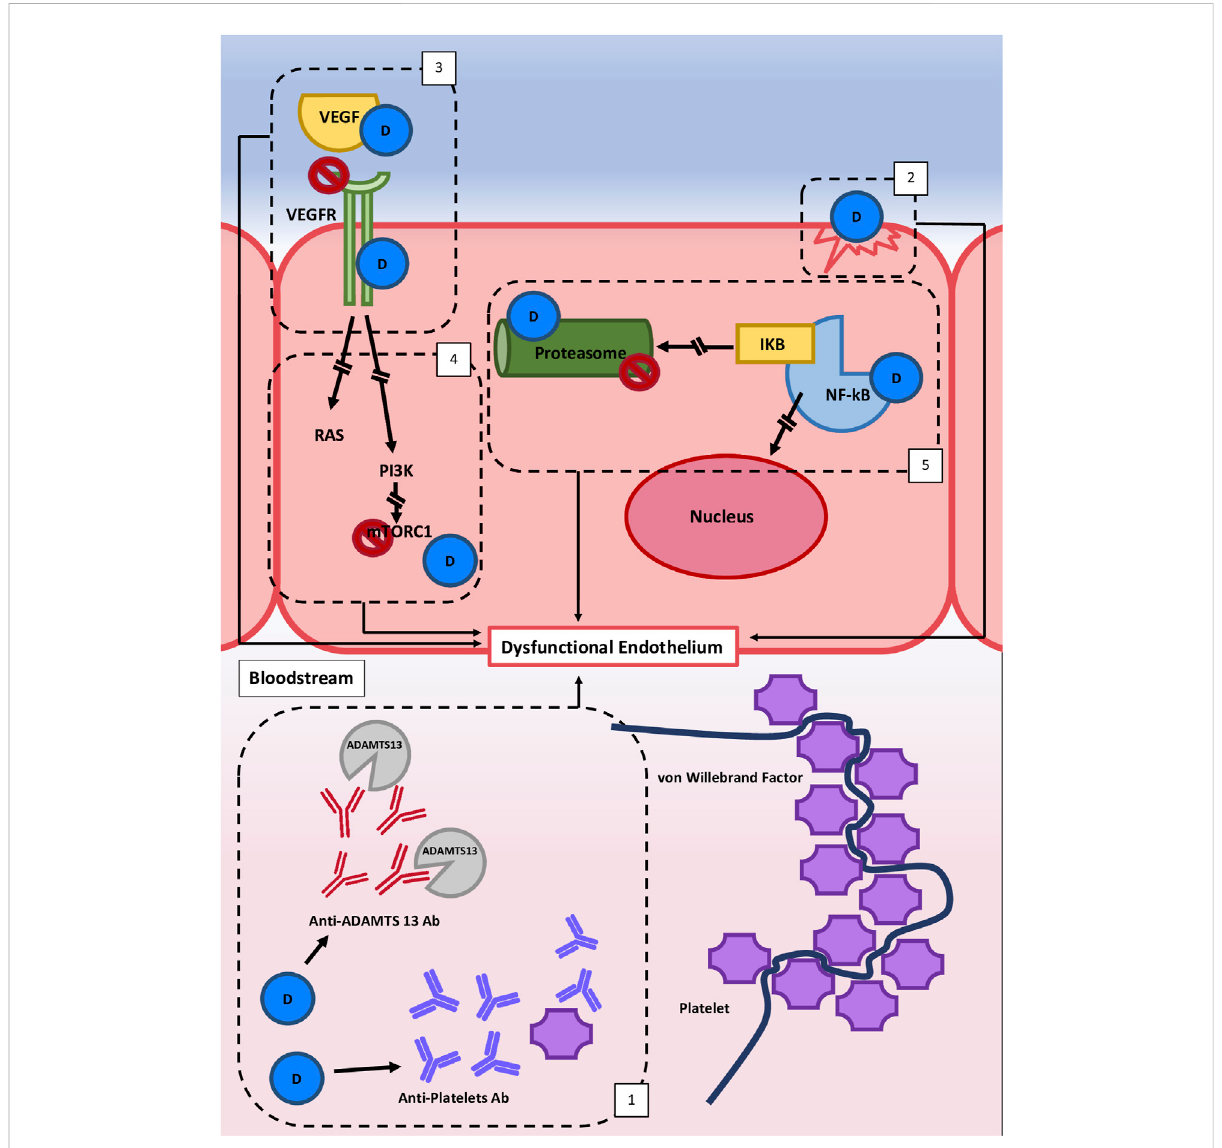
FIGURE 1 Hypothetical etiopathogenetic mechanisms involved in Drug-induced thrombotic microangiopathy (DITMA). Different etiopathogenetic mechanisms are involved in DITMAs and they all lead to endothelial dysfunction and/or platelet activation. These mechanisms are commonly distinguished in two subgroups. The fi rst group is characterized by an immune-mediated reaction (1), related to abnormal susceptibility to a drug which leads to the production of reactive antibodies that interact with endothelium, platelets and/or circulating factors. The second group is bonded by a cumulative effect dose mechanism that leads to the interruption of different pathways variously involved in the maintenance of physiological endothelium homeostasis: (2) direct endothelialdamage,(3) interference with signal proteinand their receptors (e.g. VEGFR pathway), [4] interference with signal transducers (e.g. mTOR pathway), and (5) downregulation of transcription factors (e.g., NF-kB). Legend: D, drug; VEGF, vascular endothelial growth factor; VEGFR, vascular endothelial growth factor receptor; PI3K, Phosphoinositide 3-Kinase; mTORC1 = mTOR, Complex one; NF-KB, Nuclear Factor Kappa B; IKB, Inhibitor Kappa B; Ab,